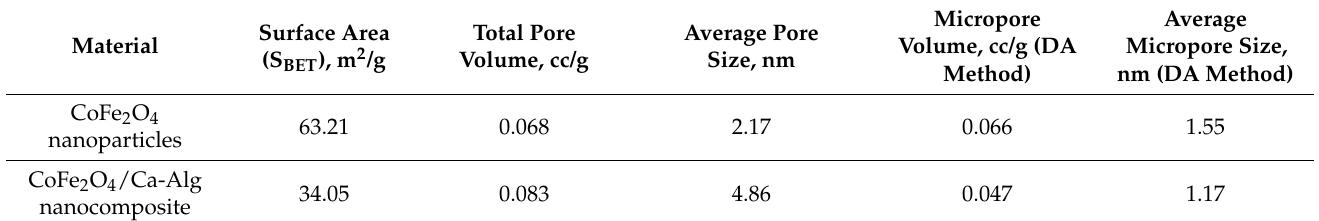
Figure 2. Illustrates ( a , b ) the N 2 adsorption–desorption isotherm curves of green synthesized CoFe 2 O 4 nanoparticles and CoFe 2 O 4 /Ca-Alg nanocomposite according to the BET method, respectively, and ( c , d ) pore size/volume as determined by the DA method for green synthesized CoFe 2 O 4 nanoparticles and CoFe 2 O 4 /Ca-Alg nanocomposite, respectively. Table 1. Represents the BET surface area and porosity properties of green synthesized CoFe 2 O 4 nanoparticles and CoFe 2 O 4 /Ca-Alg